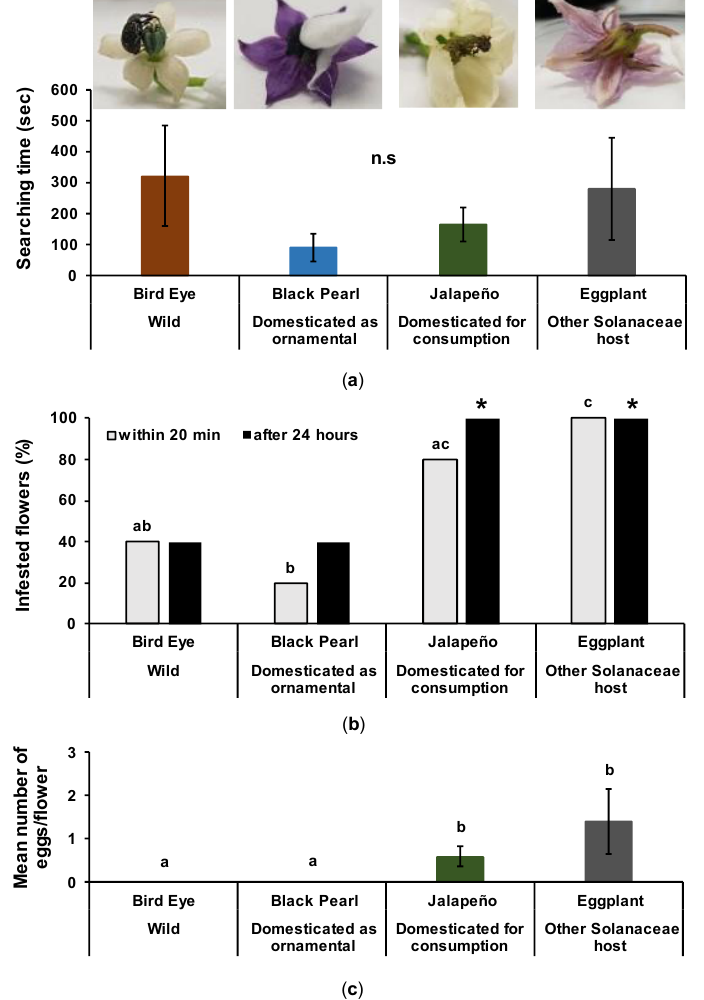
Figure 6. Pepper weevil attacks on flowers of wild pepper (Bird Eye), ornamental pepper (Black Pearl), pepper domesticated for consumption (Jalapeño), and eggplant. Searching time to find the flower ( a ), percentage of infested flowers ( b ), and mean number of eggs per flower ( c ). The differ- ences among treatments are indicated by different letters for 20 min and stars (*) for 24 h (F-test (a, c) and Chi-test (b) followed by Tukey ’s post-hoc test with Bonferroni correction: p < 0.05, N = 5). All images © Y. Chabaane.